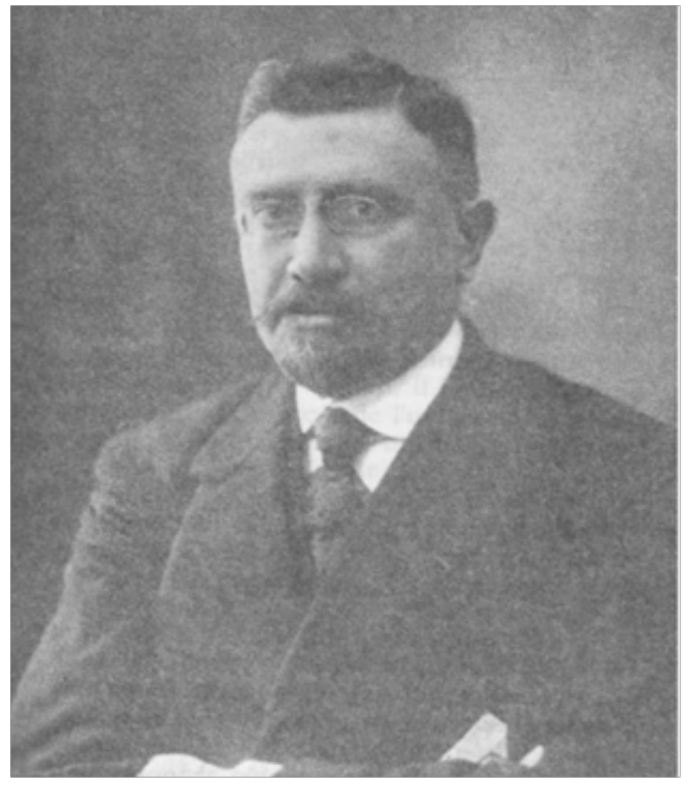
Figure 16. Manuel, Henri. Le Professeur Claude à Sainte-Anne in Nadja